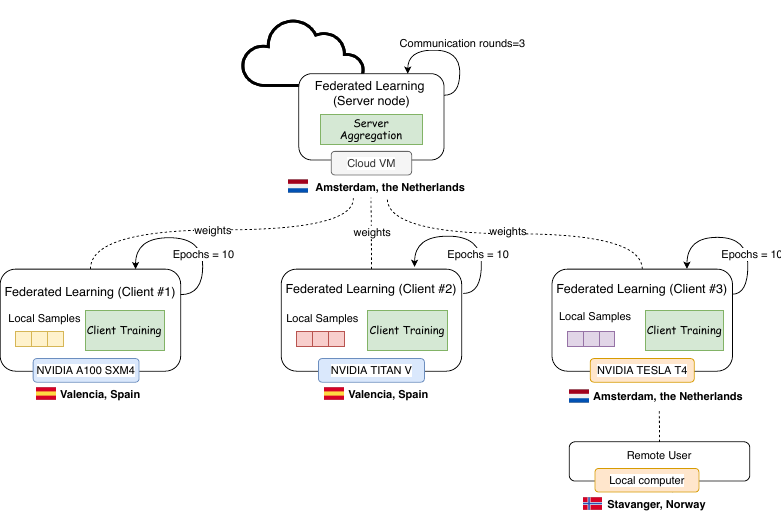
Figure 5. Implementation of the proposed solution, Notebook Federator, in a federation composed of institutions located in different countries and relying on different hardware resources.